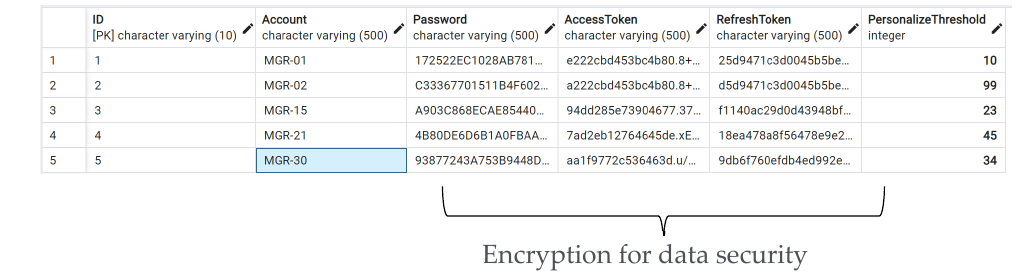
Figure 9. The results of the personalized notification setting.